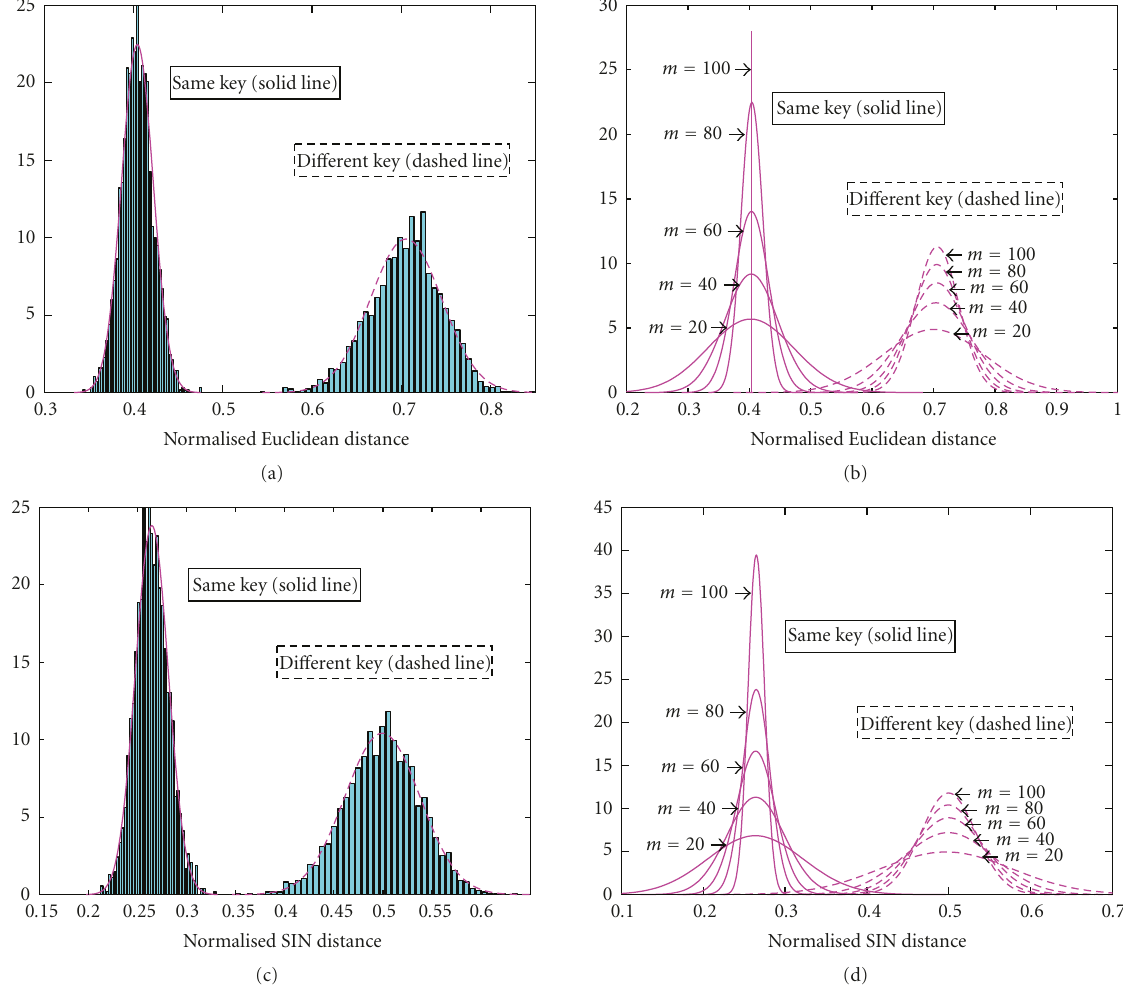
Figure 4: Gaussian approximation of the distribution of (a) normalized Euclidean distance (NED), (c) normalized SIN distance (NSD), with n = 100, m = 80. Distribution of (b) NED, and (d) NSD, at di ff erent projection dimensionality in same key and di ff erent key